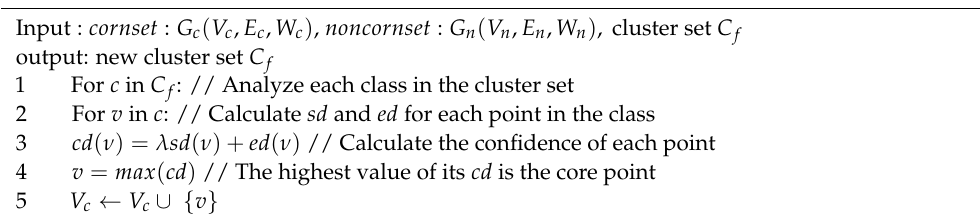
Algorithm 4. Reselect the Core